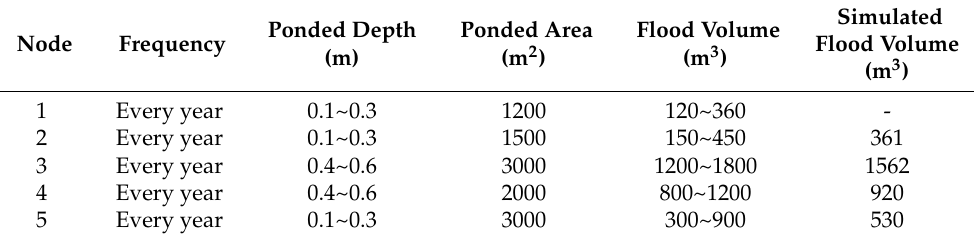
Table 3. Pounding areas and flood volume in field survey and